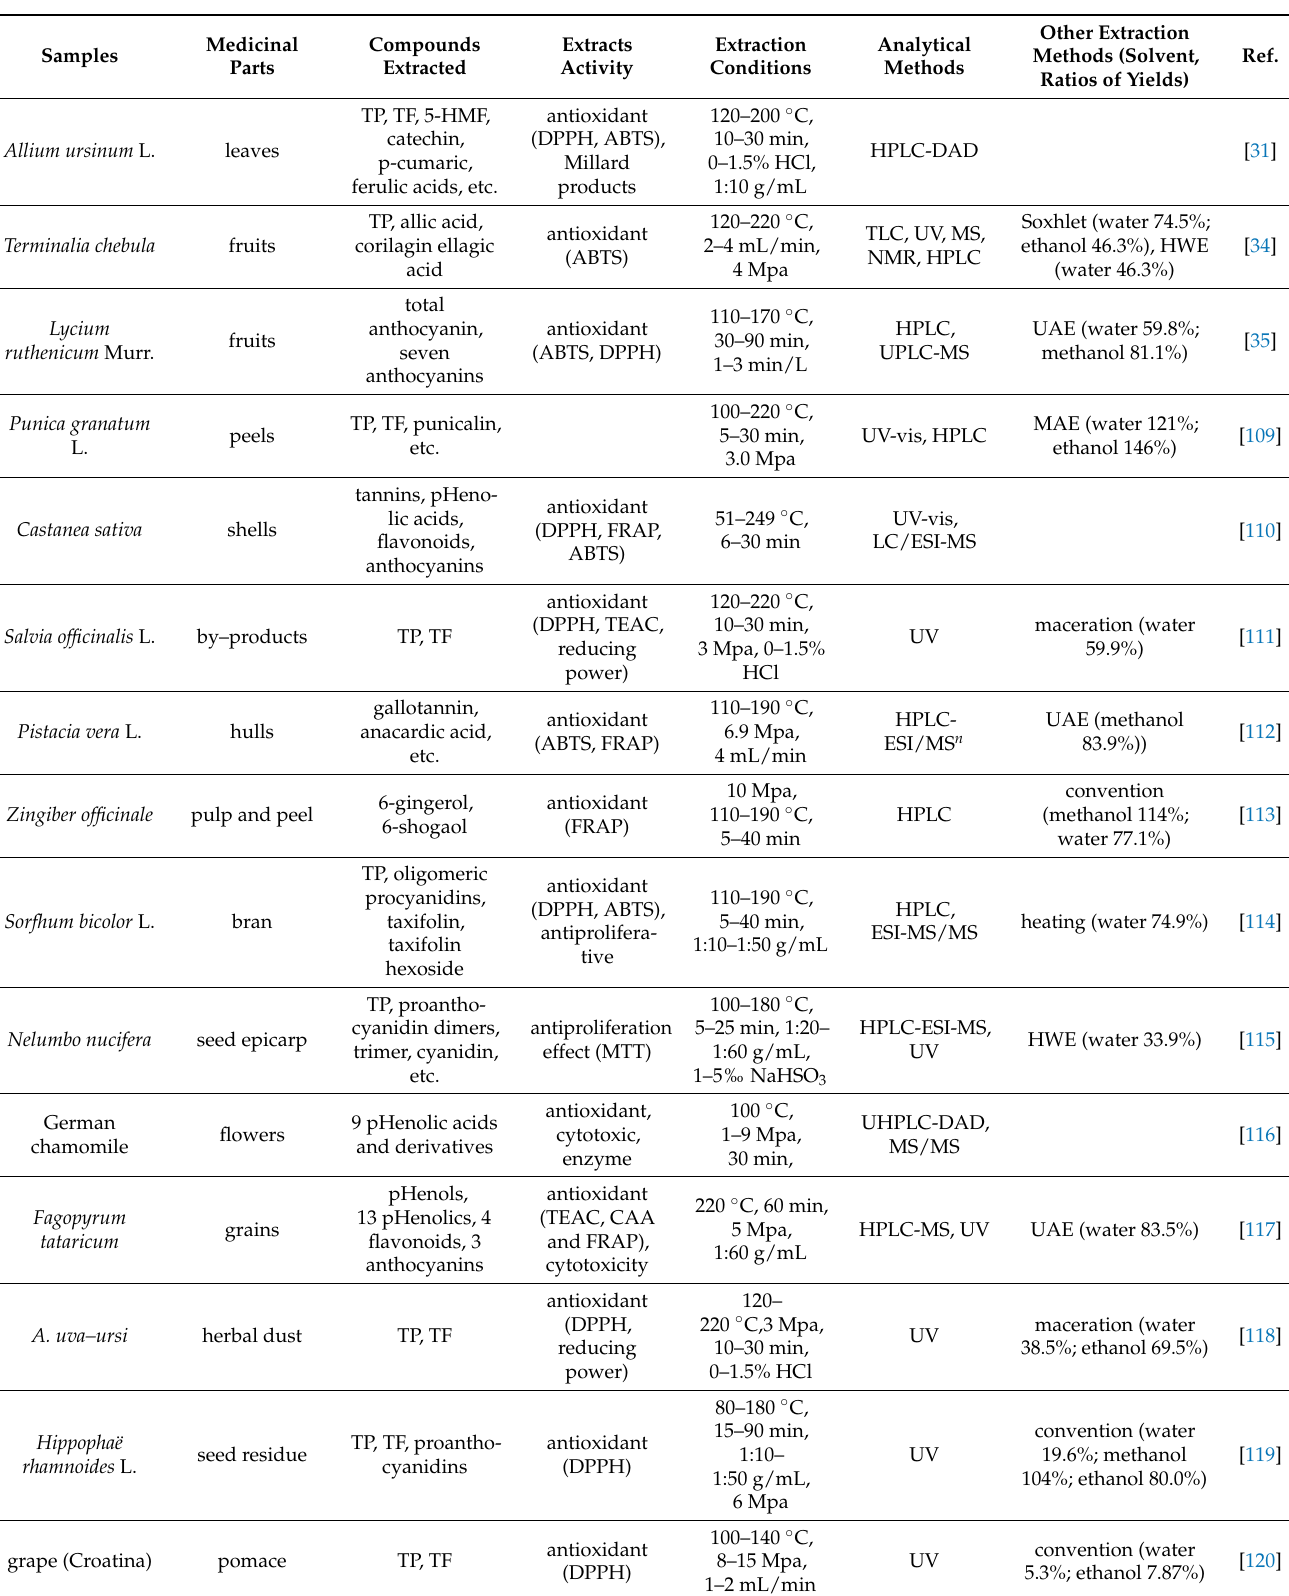
Table 2. Subcritical water extraction of